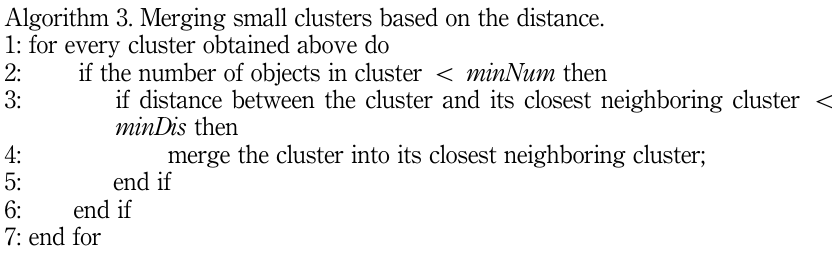
Algorithm 3. Merging small clusters based on the